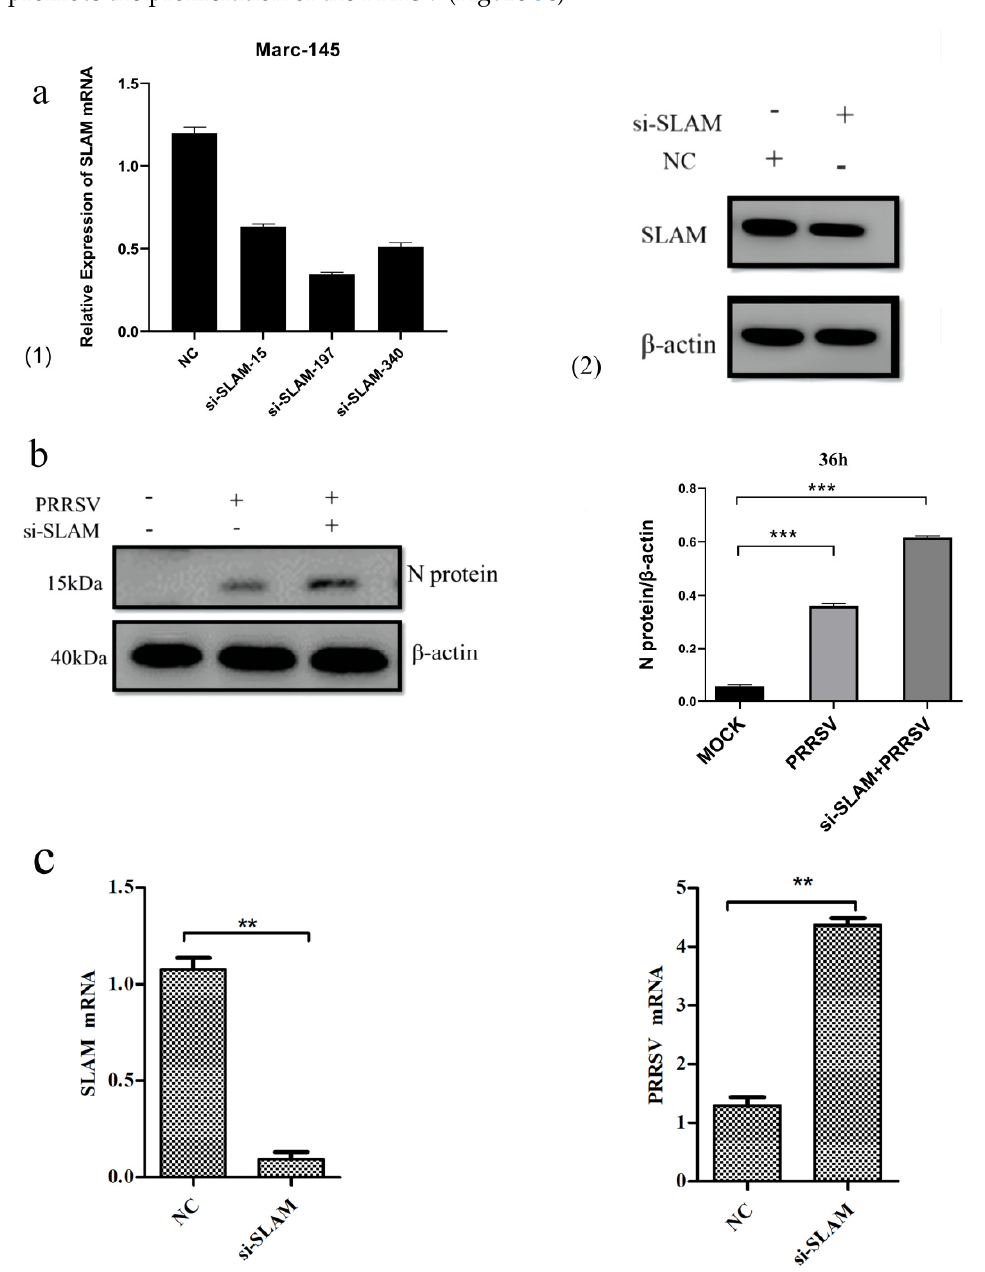
Figure 3. Knockdown of SLAM enhances PRRSV replication. ( a1 ) Different synthetic si-SLAM interfering plasmids were transfected into Marc-145 cells, and the mRNA level of the SLAM gene was detected by qRT-PCR 24 h later. ( a2 ) Si-SLAM-197 was transfected into Marc-145 cells, and the changes in the SLAM gene in the cells were detected by western blot 24 h later. ( b ) Effect of SLAM gene on PRRSV proliferation was detected by western blot. ( c ) Effect of siRNA interference SLAM gene on PRRSV proliferation was detected by qRT-PCR. Note: ** means significant difference ( p < 0.01), *** means extremely significant difference ( p < 0.001).